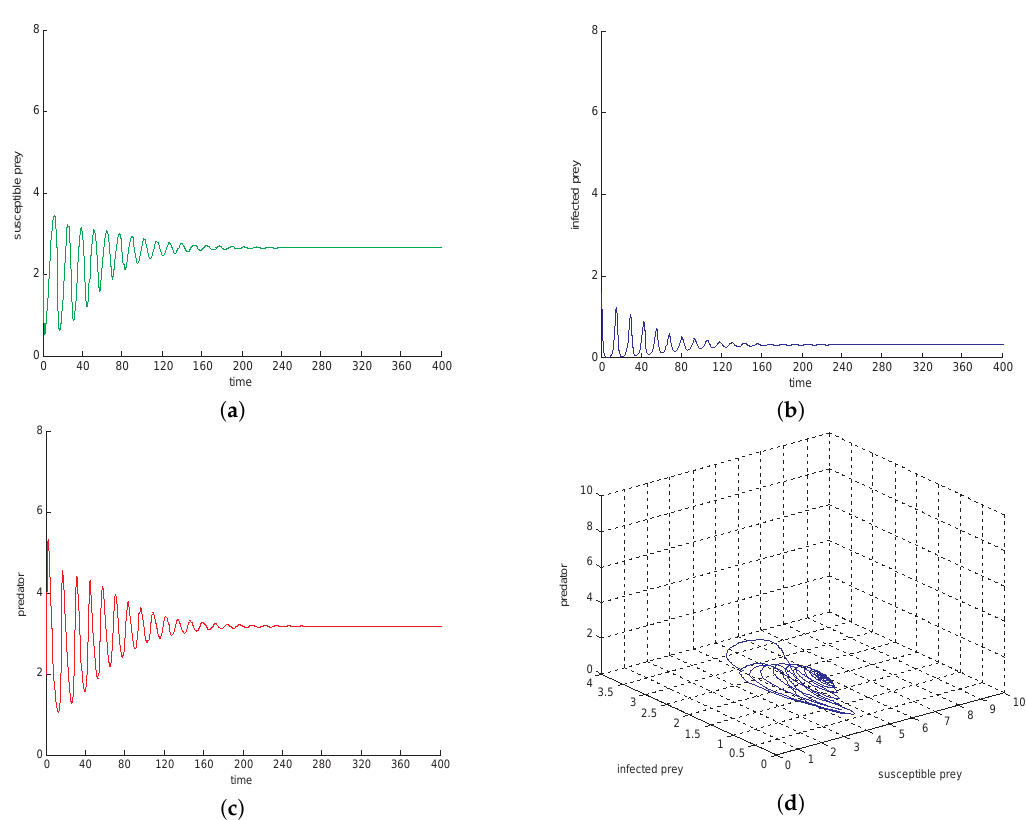
Figure 4. ( a – c ) time series evolution of the populations of system (1); ( d ) phase-space trajectories corresponding to the stabilities of the population with the parameters a = 2, b = 0.3, f = 0.65, h 1 = 0.5, h 2 = 0.3, d = 0.2, K =